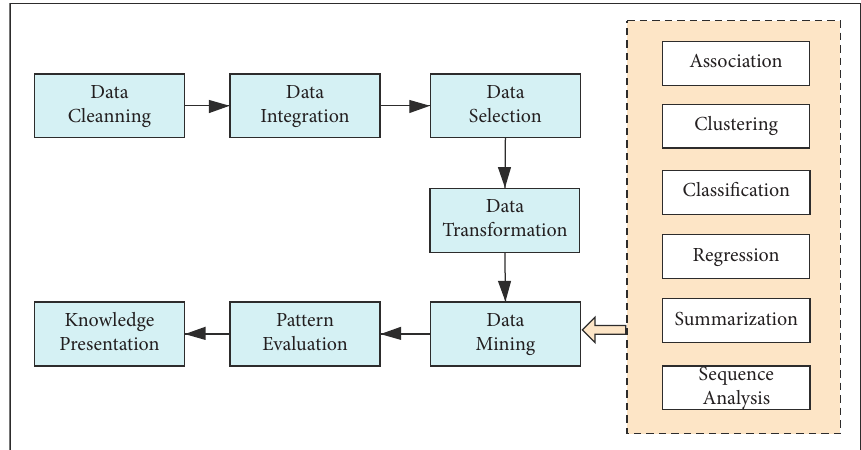
Figure 1: The generic framework of